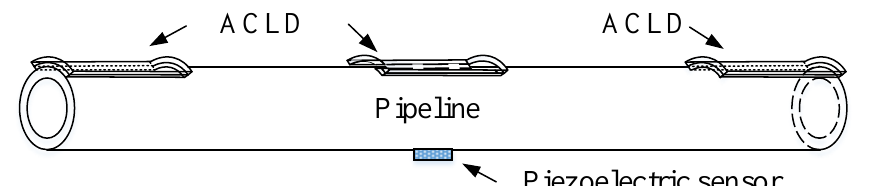
Figure 8. Schematic diagram of pipeline in case 2.